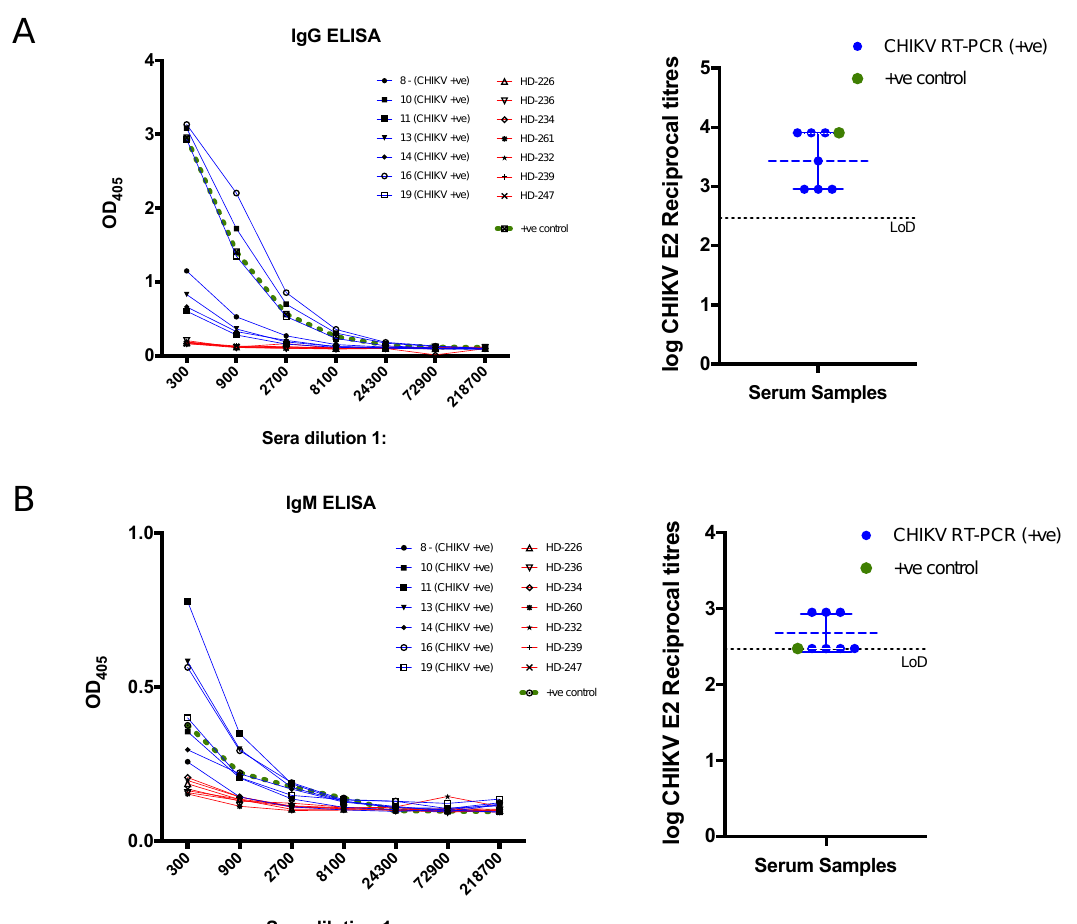
Figure 3. ELISA assays to assess the reactivity of human sera. Chikungunya virus (CHIKV)-infected patients (blue) confirmed by RT-PCR, sera obtained from healthy donors (HD) from a non-endemic region (red) and a CHIKV-positive control serum (green). ( A ) The graph of CHIKV E2 IgG OD405 against sera dilutions (left) and the corresponding endpoint log reciprocal titres (right). ( B ) The graph of CHIKV E2 IgM OD405 (left) and the corresponding endpoint log reciprocal titres (right). The black dotted line indicates the limit of detection (LoD), which corresponds to 1:300 serum dilution on a log scale.